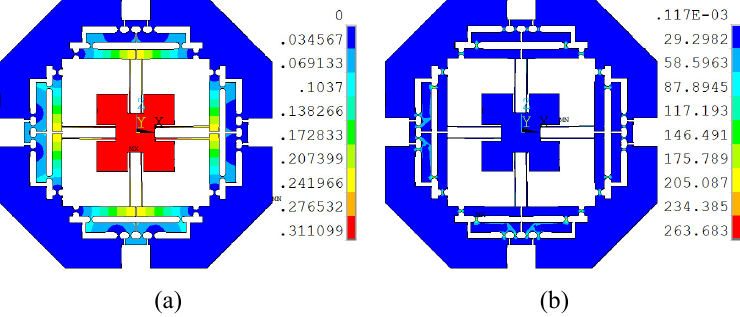
Figure 13. The verification of FEA: (a) deformation result; (b) stress